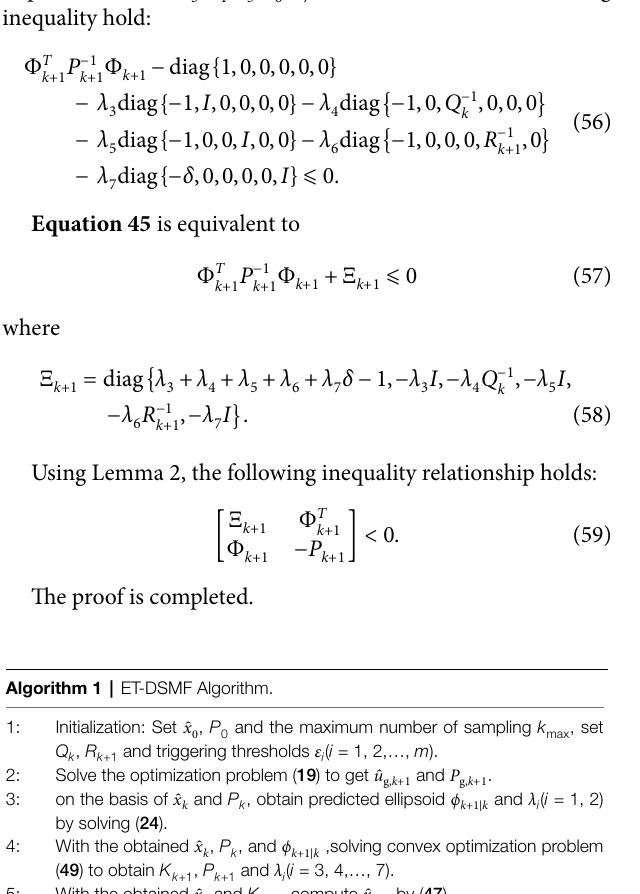
FIGURE 4 | IEEE 13 PDN test